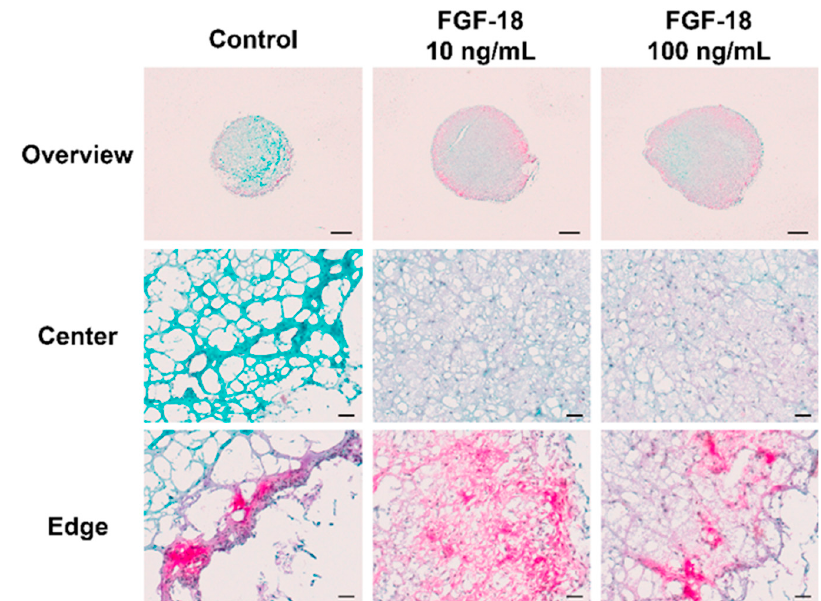
Figure 5. Representative Safranin O/Fast Green-stained transverse sections of bovine (healthy) nucleus pulposus cells encapsulated in FBG-HA hydrogel and stimulated with 0, 10, or 100 ng/mL FGF-18 after 14 days of culture. The red and green staining reveal proteoglycan and collagen deposition respectively. Scale bar: overview—1000 µm, center and edge—50 µm.